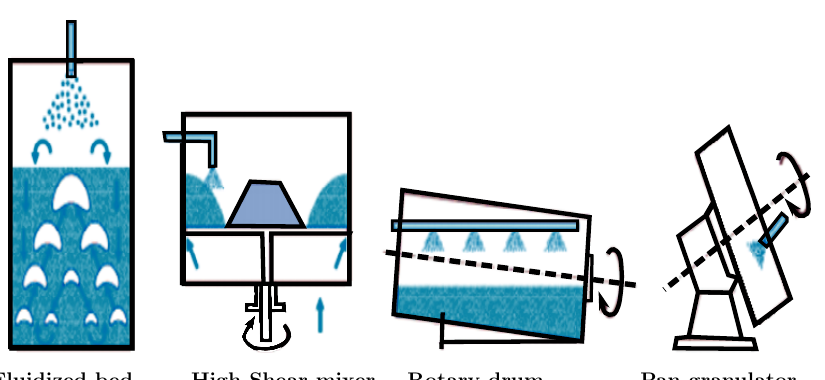
Figure 1. Wet-granulation technologies. Inspired from Saleh and Guigon